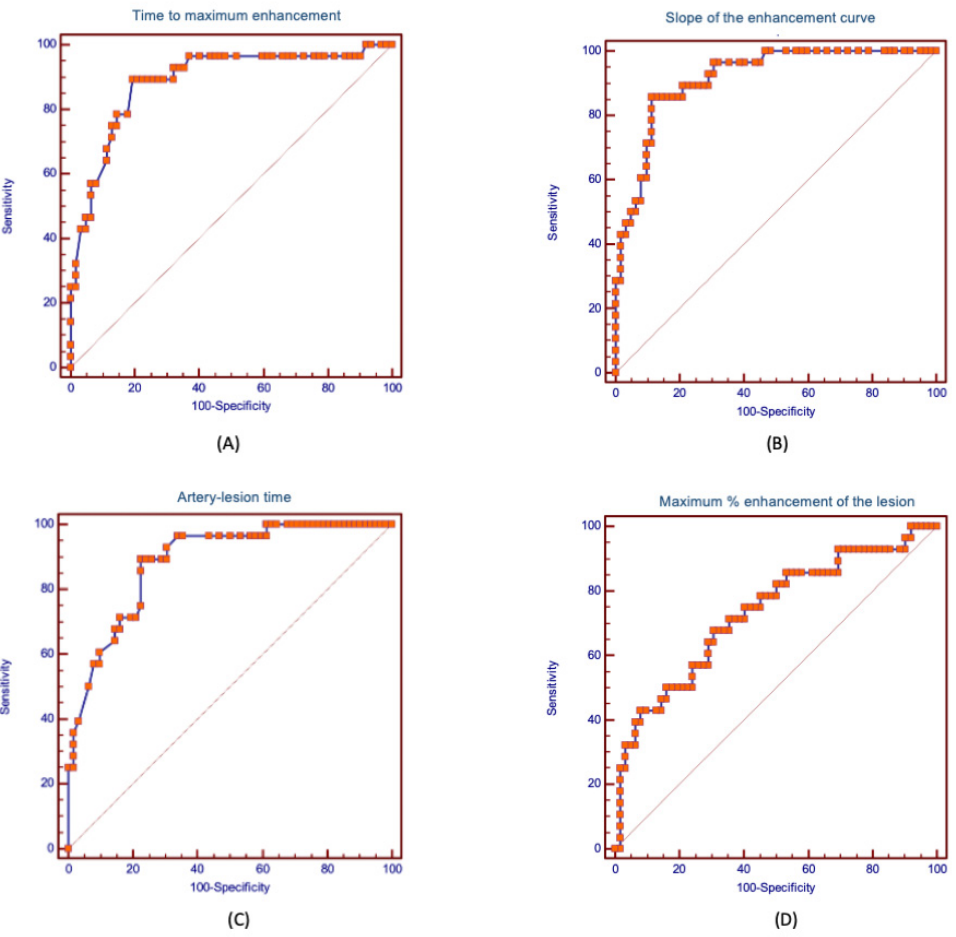
Figure 5. Receiver operating curves (ROCs) for: ( A ) time to maximum enhancement; ( B ) slope of the enhancement curve; ( C ) artery-lesion time; ( D ) maximum percentage enhancement of the lesion.